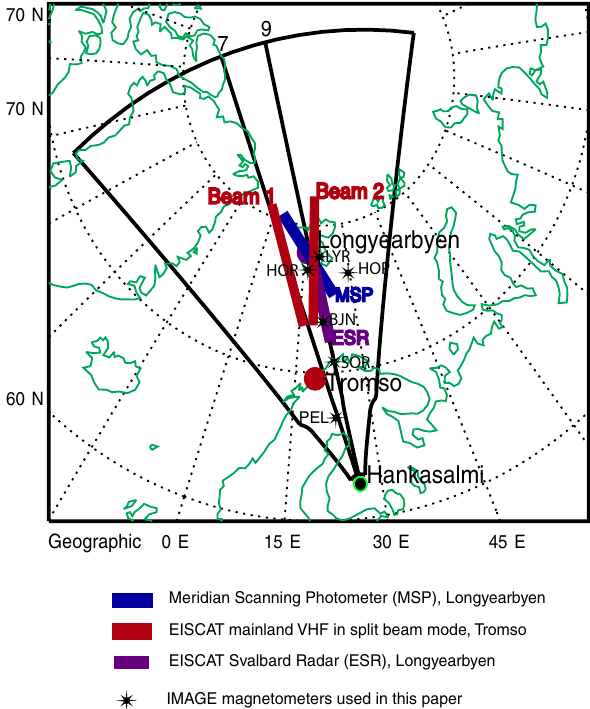
Fig. 1. Map indicating the location of the fields-of-view of the in- struments used in this study. Only the IMAGE magnetometer sta- tions referred to in the text are